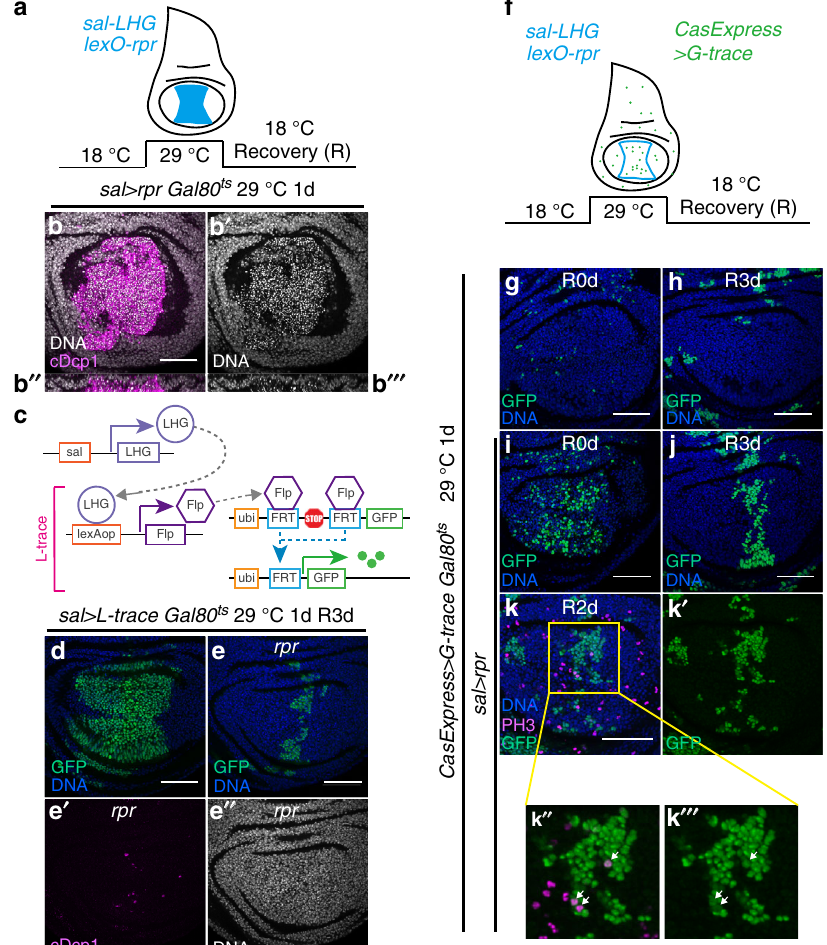
Fig. 2 Cells can survive rpr -induced executioner caspase activation. ( a ) A schematic showing the spalt ( sal ) domain (blue region) and the design for experiments in ( b , d , and e ). Transgenes were expressed only at 29 °C. ( b ) Overexpression of rpr for 1d induced extensive apoptotic cell death (cDcp1 staining and pyknotic nuclei). ( b ” ) and ( b ”’ ) show the vertical sections through the disc in ( b ). ( c ) A schematic shows the use of L-trace to trace LHG -expressing cells. ( d ) sal-LHG L-trace Gal80 ts disc after 1d at 29 °C and 3d at 18 °C. GFP labels cells descended from the sal-LHG domain. ( e ) sal-LHG lexO-rpr L-trace Gal80 ts disc after 1d at 29 °C and 3d at 18 °C. GFP labels cells have experienced transient rpr overexpression and their progeny. ( f ) A schematic of experiments in ( g – k ). The blue line circles the sal domain. ( g , h ) lexO-rpr CasExpress G-trace Gal80 ts disc right after 1d at 29 °C ( g ) and after 3d recovery at 18 °C ( h ). ( i – k ) sal-LHG lexO-rpr CasExpress G-trace Gal80 ts disc right after 1d at 29 °C ( i ), after 3d recovery at 18 °C ( j ), and after 2d recovery at 18 °C ( k ). In ( g – k ), GFP marks cells that have survive executioner caspase activation. In ( k ), PH3 labels mitotic cells. White arrows point to several examples of mitotic CasExpress + cells. In all images, scale bar is 50 μ